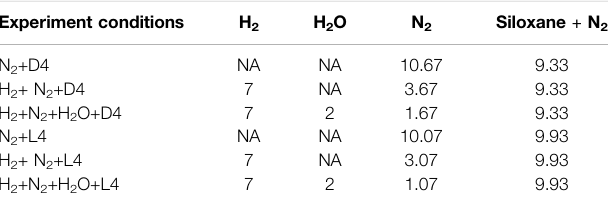
TABLE 1 | Flow rate (sccm) of anode side gases supplied to YSZ pellet during different experiments. Experiment